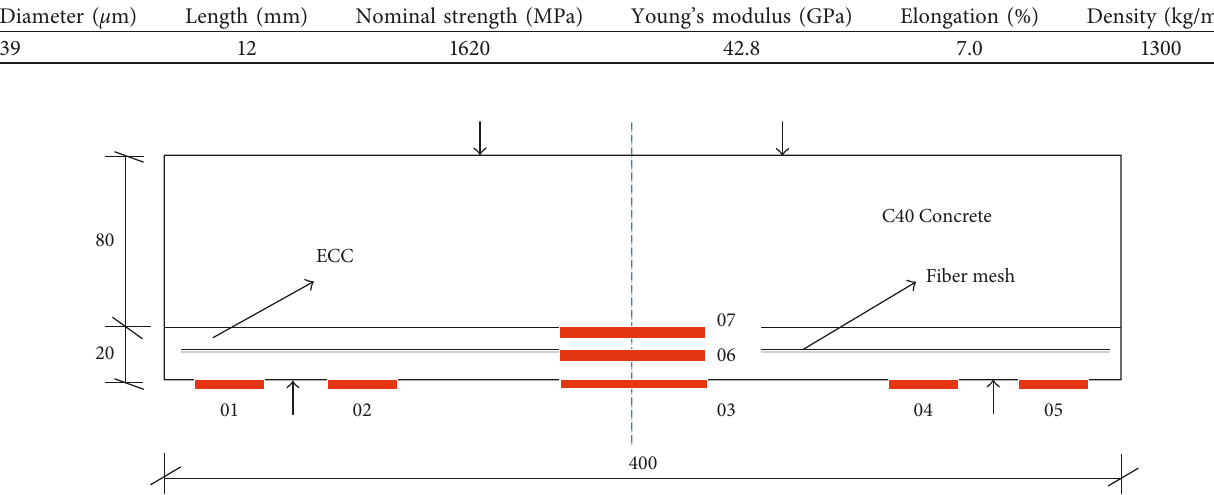
Figure 1: Configurations of strain-testing points of the composite